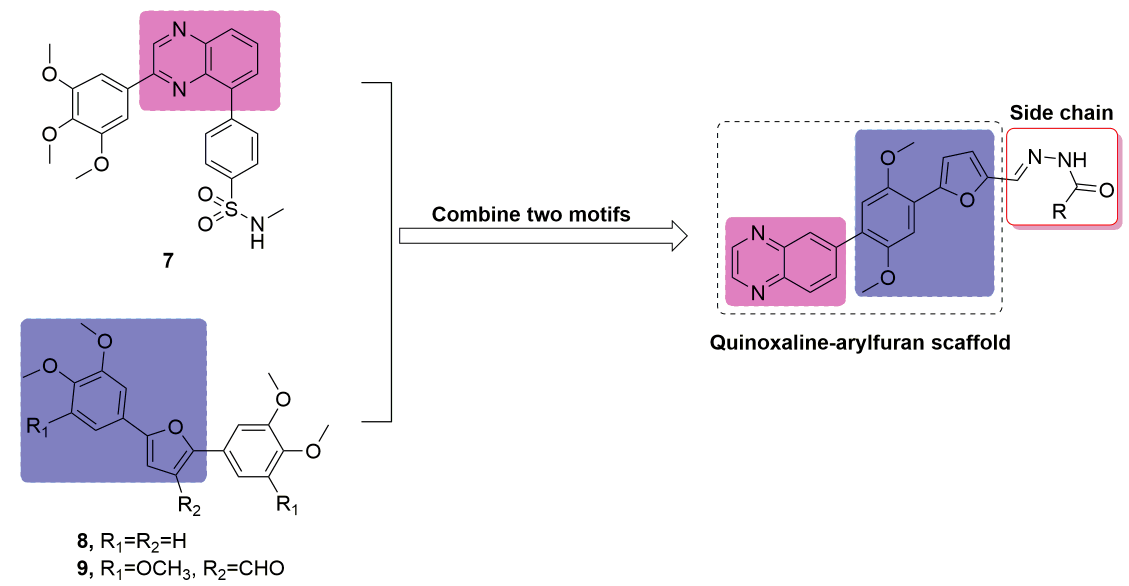
Figure 2. Design of new anticancer agents with a novel quinoxaline – arylfuran scaffold.